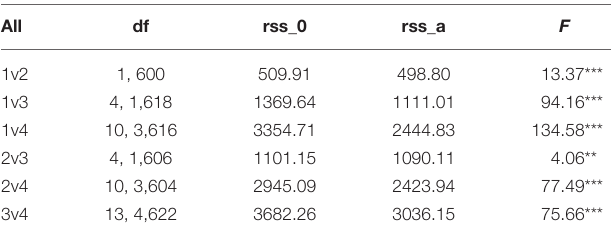
TABLE 3 | F -test between each pair of four categories of